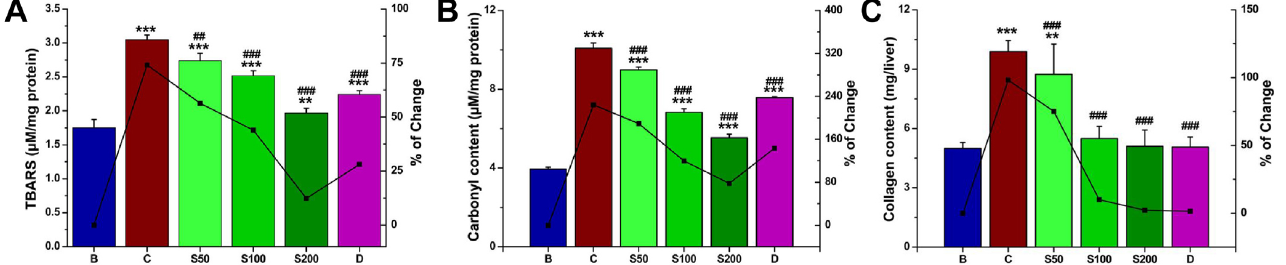
Fig 5. Effect of DBME on biochemical parameters. (A) Hepatic lipid peroxidation levels, (B) protein oxidation levels, (C) collagen content. Mice were randomly divided into six groups (blank, B; control, C; 50 mg/kg b.w. DBME, S50; 100 mg/kg b.w. DBME, S100; 200 mg/kg b.w. DBME, S200; desirox group, D) and treated as described in ‘ experimental design ’ section. Values are expressed as mean ± SD of six mice. ** p < 0.01, *** p < 0.001 compared with blank and ##p < 0.01, ###p < 0.001 compared with